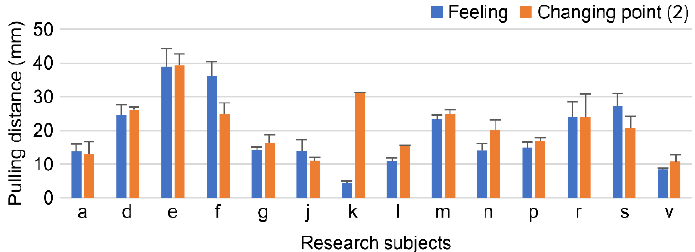
Figure 9. Sensation and point of change when you begin to feel comfortable.